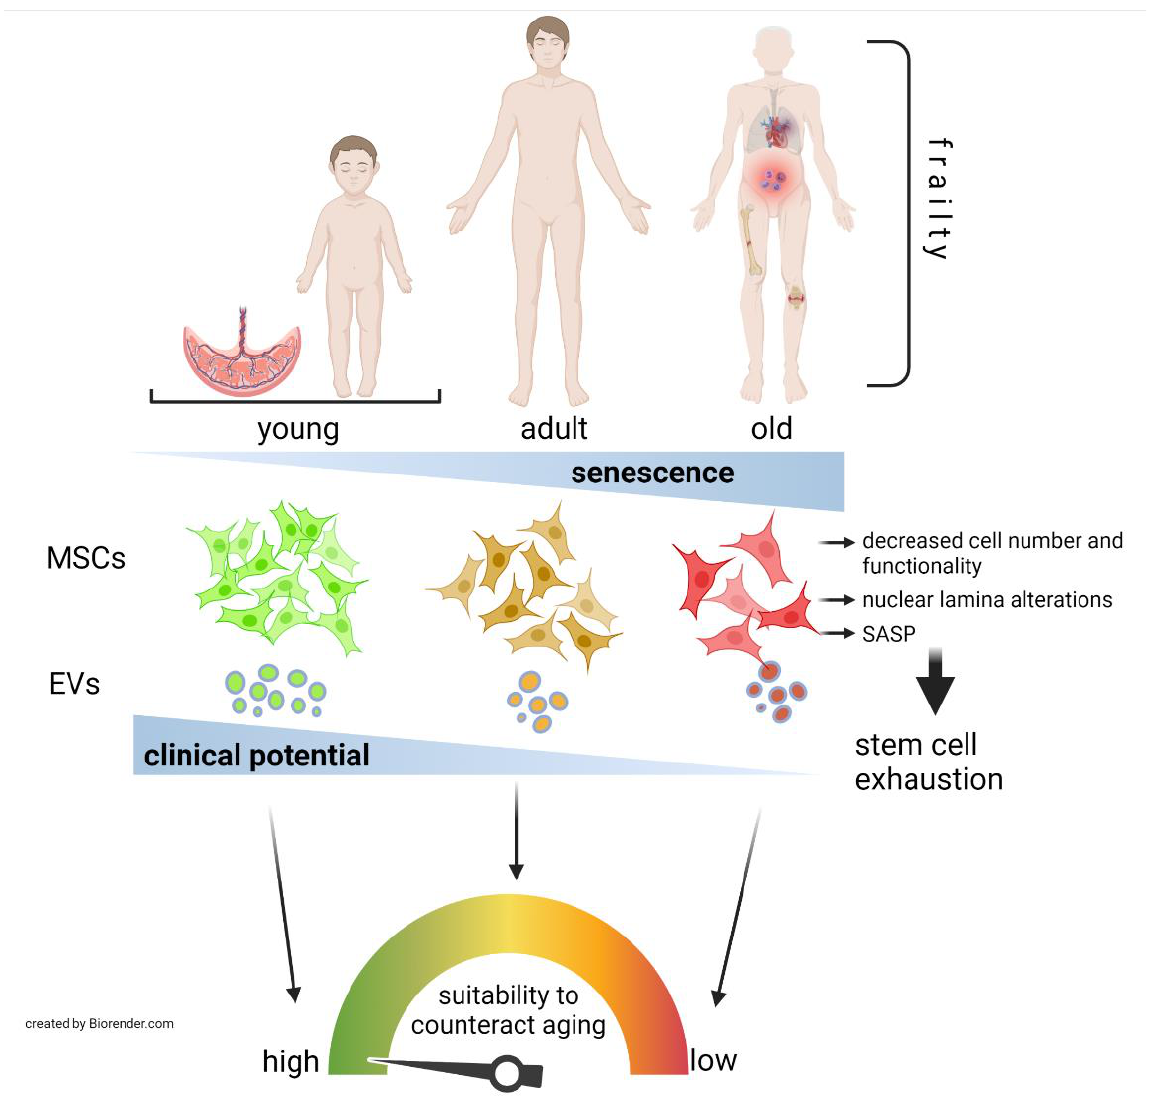
Figure 1. Age-related suitability of MSCs or derived products to be used as therapeutics to counteract human aging or age-related pathologies. MSCs’ number and functional capabilities diminish as the donor’s age increases, with those isolated from neonatal tissues, or their EVs, such as umbilical cord MSCs showing the greatest clinical potential. Thus, elderly individuals affected by systemic conditions such as inflammation and frailty or by age-related pathologies such as cardiovascular disease, acute respiratory distress syndrome (shown in severe COVID-19 patients) and musculoskeletal conditions (fractures, OA) among others, would be especially benefitted by young MSC-based treatments.